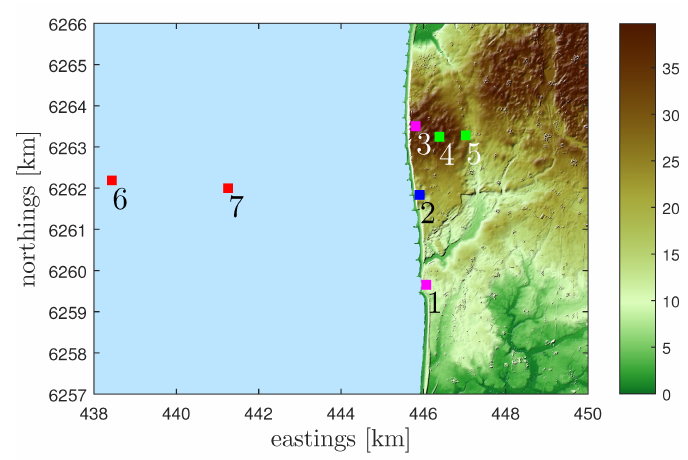
Figure 2. Topographic description of RUNE’s coastal experimental area based on a digital surface model (UTM32 WGS84, Zone 32V). The positions of the lidars are shown with different markers (see Table 1 for details). The colorbar indicates the height